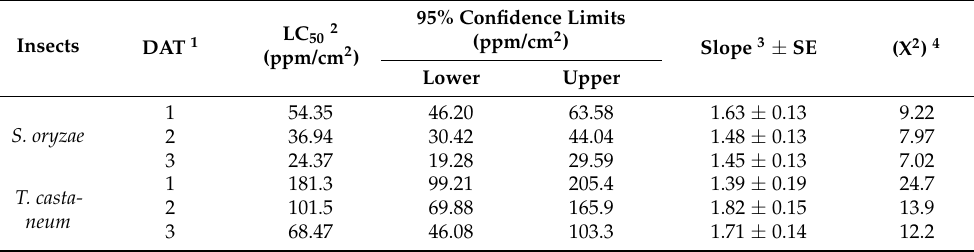
Table 3. The LC 50 values of S. chinensis oil recorded against S. oryzae and T. castaneum adults following contact